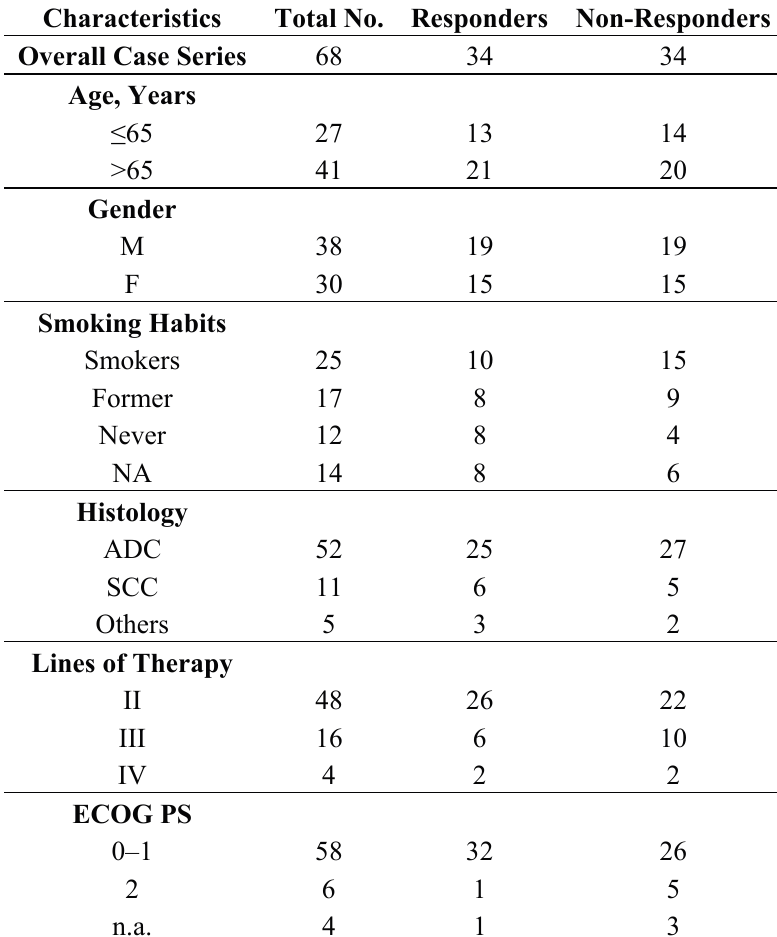
Table 1. Patient